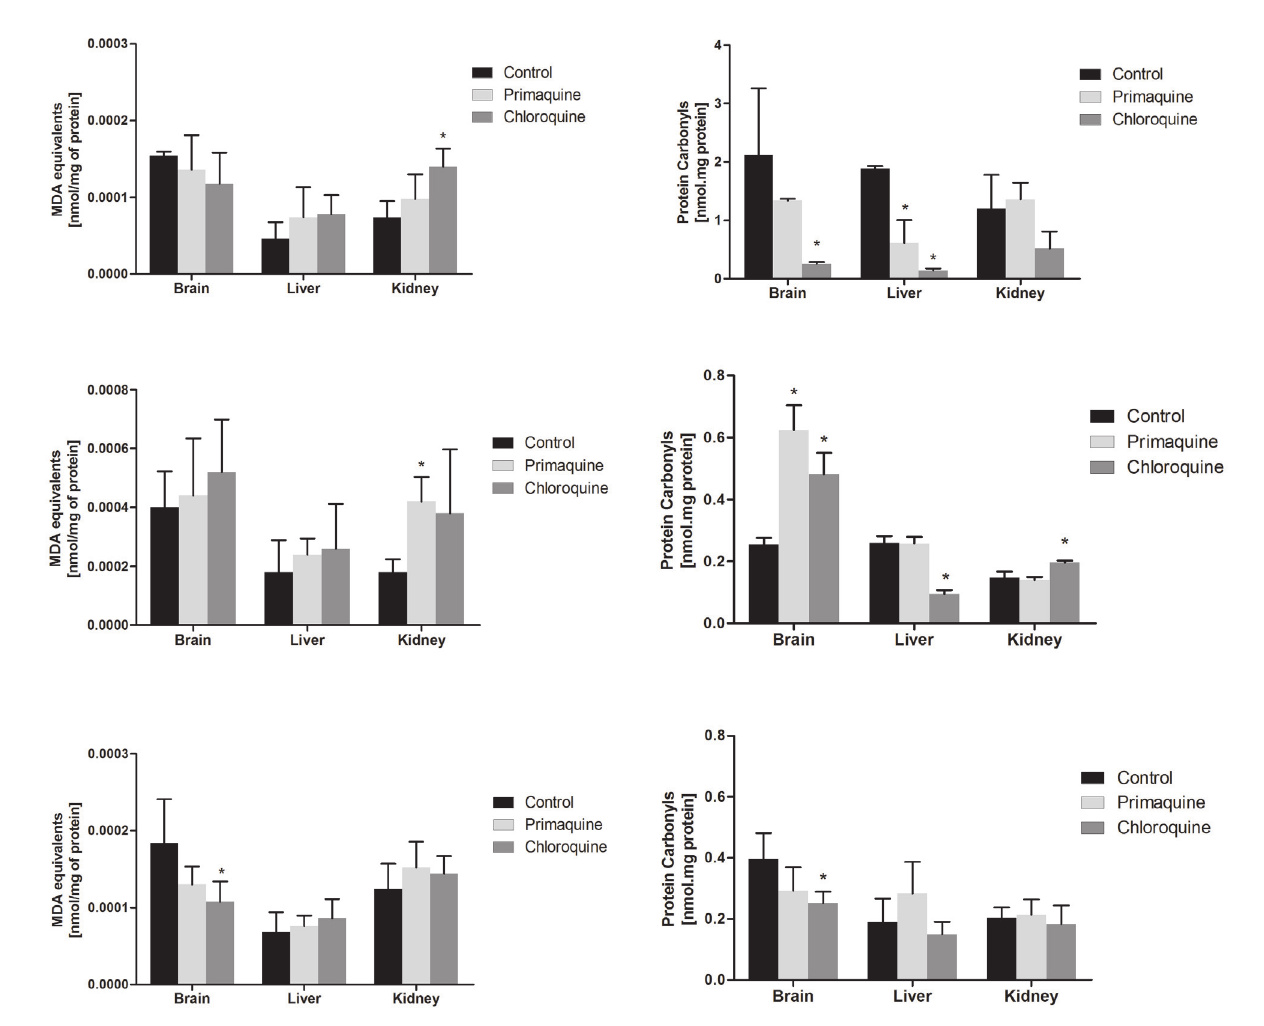
Figure 5 - Effect of 7, 14 and 21 days of administration of primaquine and chloroquine on carbonyls protein formation levels in brain, liver and kidney of rats (n = 7 per group). Data were analyzed by one-way analysis of variances followed by the Tukey test when F was significant. Values are expressed as mean ± S.D. *p < 0.05 compared to control group.